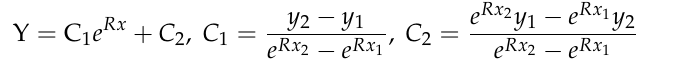
Figure 2. Geometry of the fundamental tapered slot antenna (TSA): ( a ) front side, ( b ) back side. The exponential slot is guided by the following